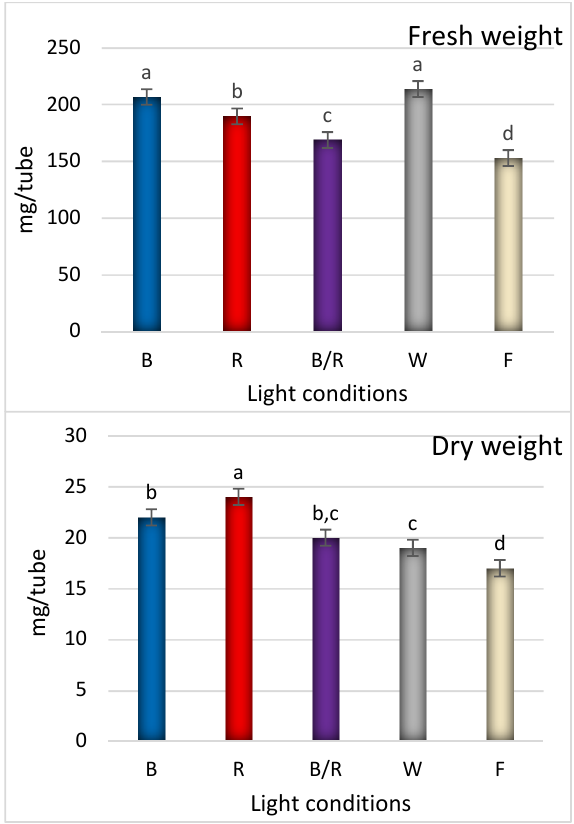
Figure 3. Morphology of D. forrestii shoots cultured under various light conditions: (B) blue, (R) red, (B/R) blue/red, (W) white, (F) fluorescent. Bar 1 cm.